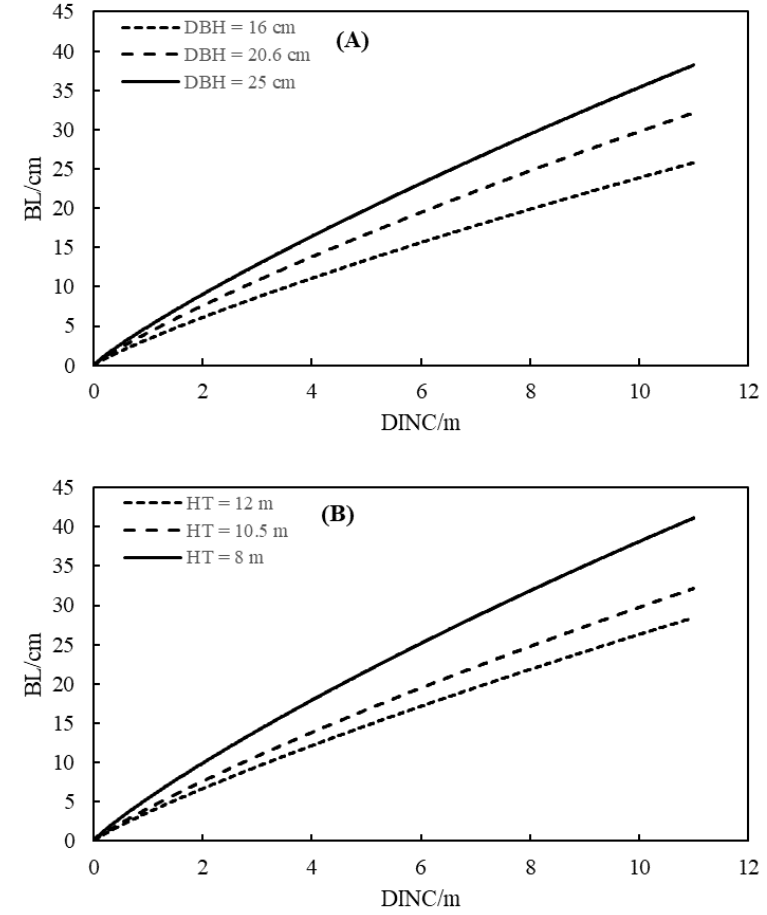
Figure 5. Effect of DBH ( A ) and HT ( B ) on branch length with an increasing DINC within the entire crown for the planted Korean crown for the planted Korean pine.